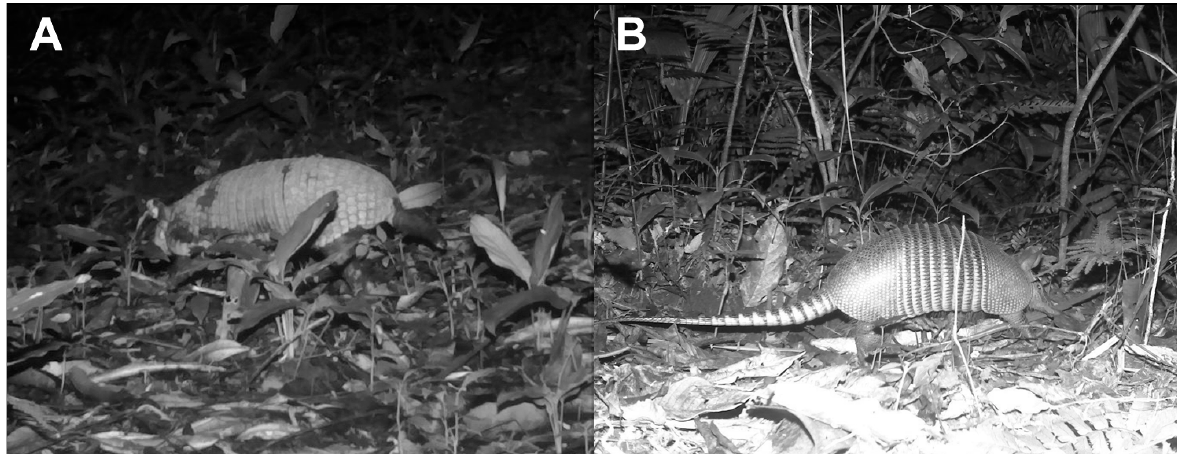
Figure 2. A. A camera trap image of a Northern Naked-tailed Armadillo from June 2014 in the Cockscomb Basin Wildlife Sanctuary, Belize. B. A camera trap image of a Nine-banded Armadillo from the same survey, which shows different morphological features (i.e. a longer armored tail, and long narrow snout) compared to the Northern Naked-tailed